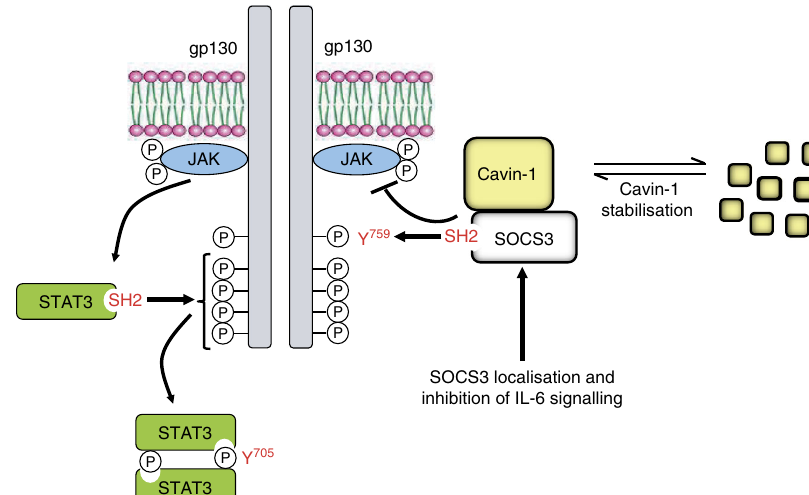
Fig. 9 Model of novel functional interactions between SOCS3